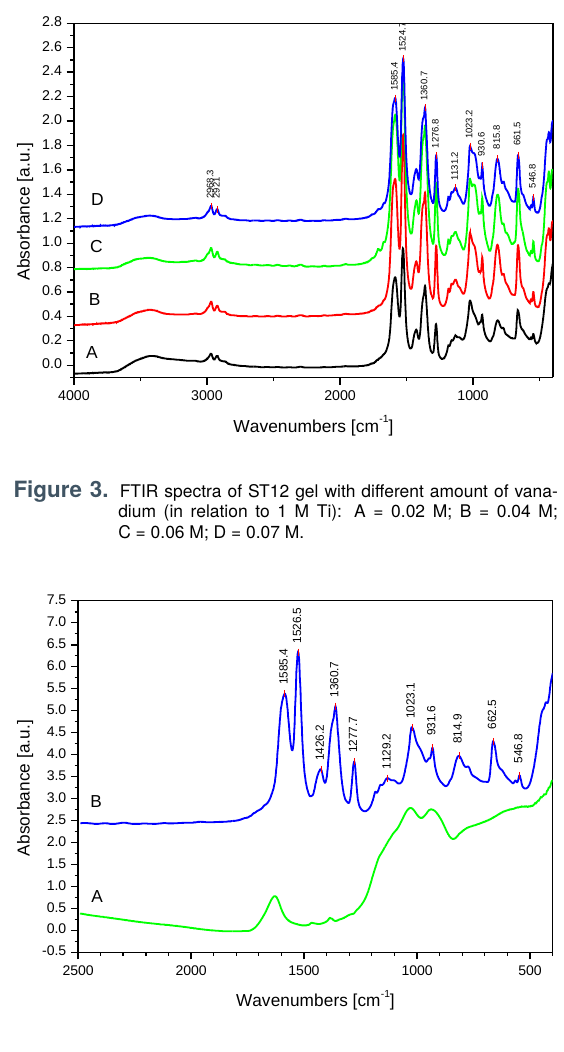
Figure 4. FTIR spectra of ST12 gel, V = 0.02 M: A) without ACC; B) with ACC Fig.4. FTIR spectra of ST12 gel, V = 0.02M: A - without ACC; B - with ACC